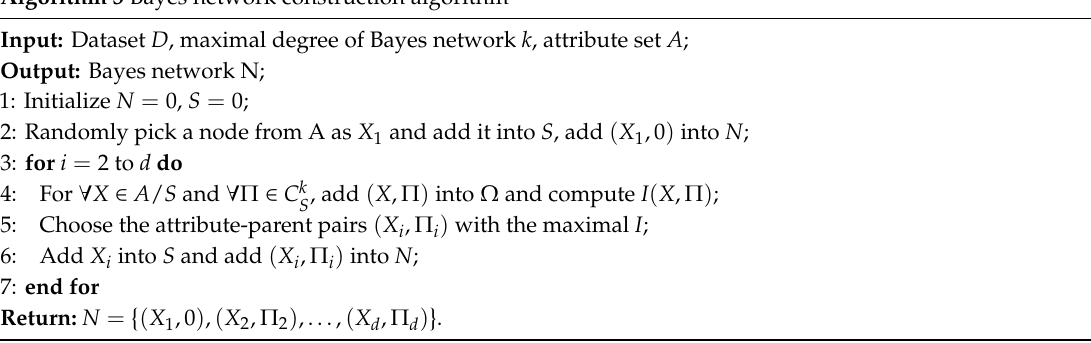
Algorithm 3 Bayes network construction